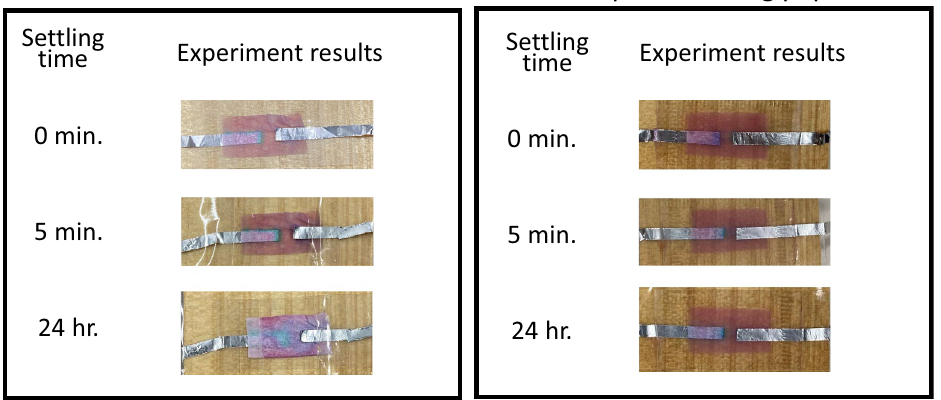
Figure 12. Color retention time of the proposed color-change RFID tag with the nonlaminated/laminated anthocyanin pH-indicating paper.